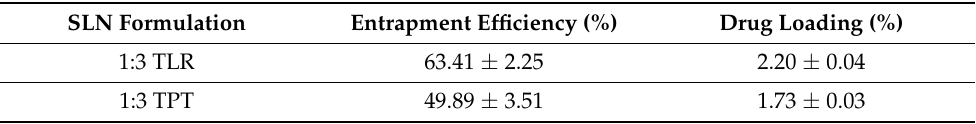
Table 2. Entrapment efficiency and drug loading.